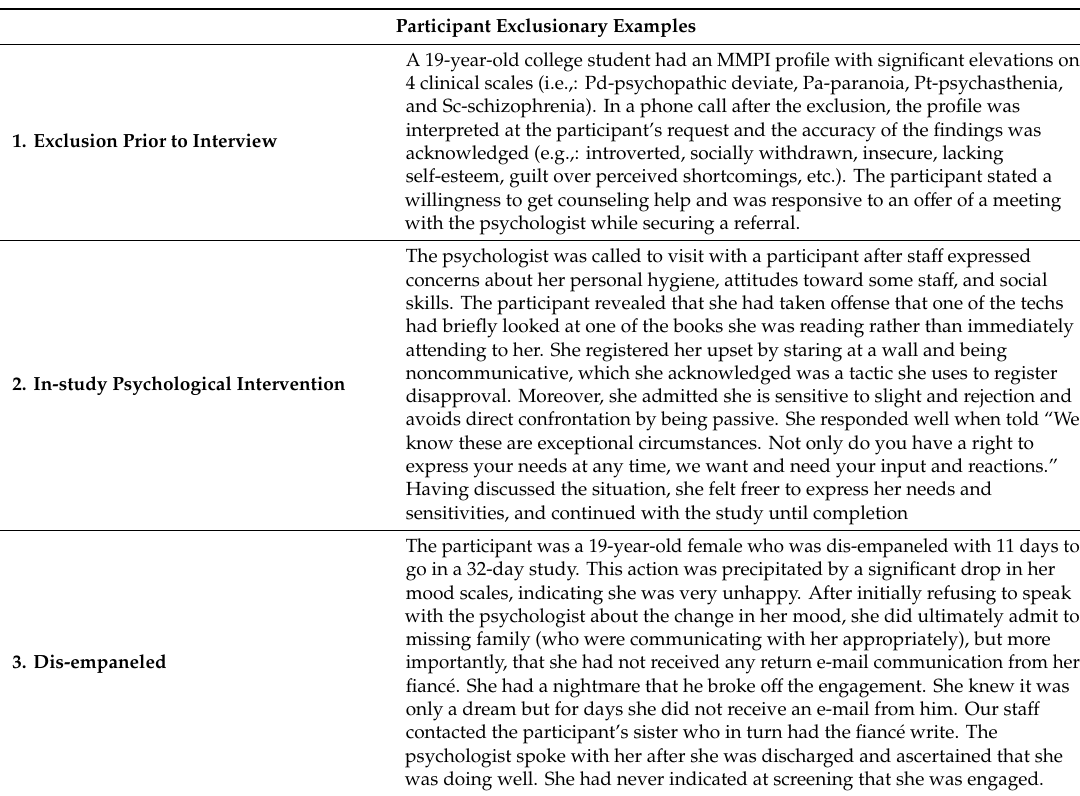
Table 5. Participant exclusionary